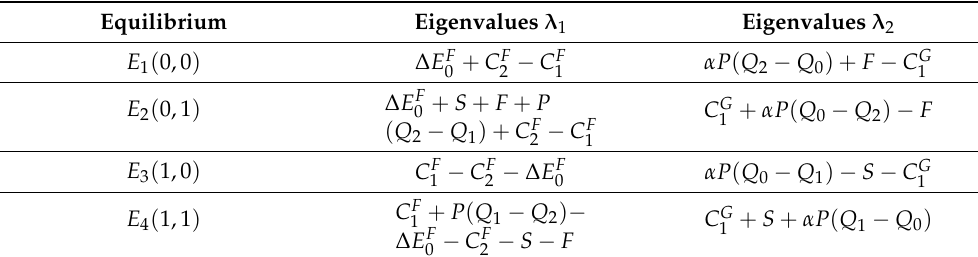
Table 3. Eigenvalues of the Jacobian matrix of the evolutionary game between the enterprise and the